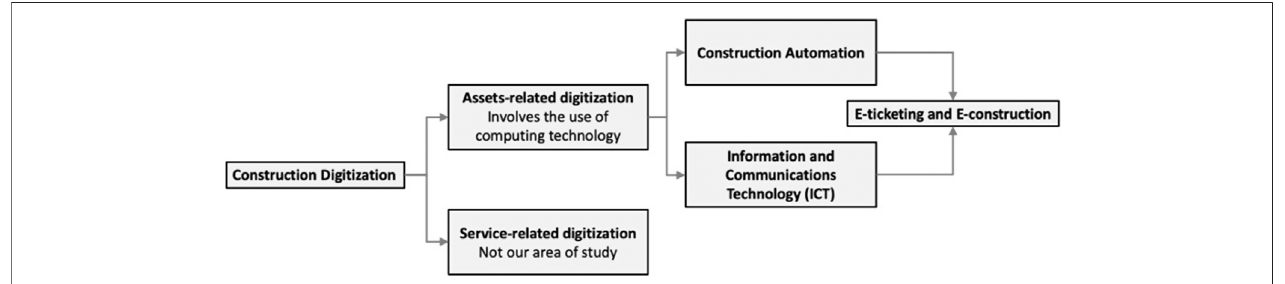
FIGURE 2 | Hierarchy of digitization in the construction industry.